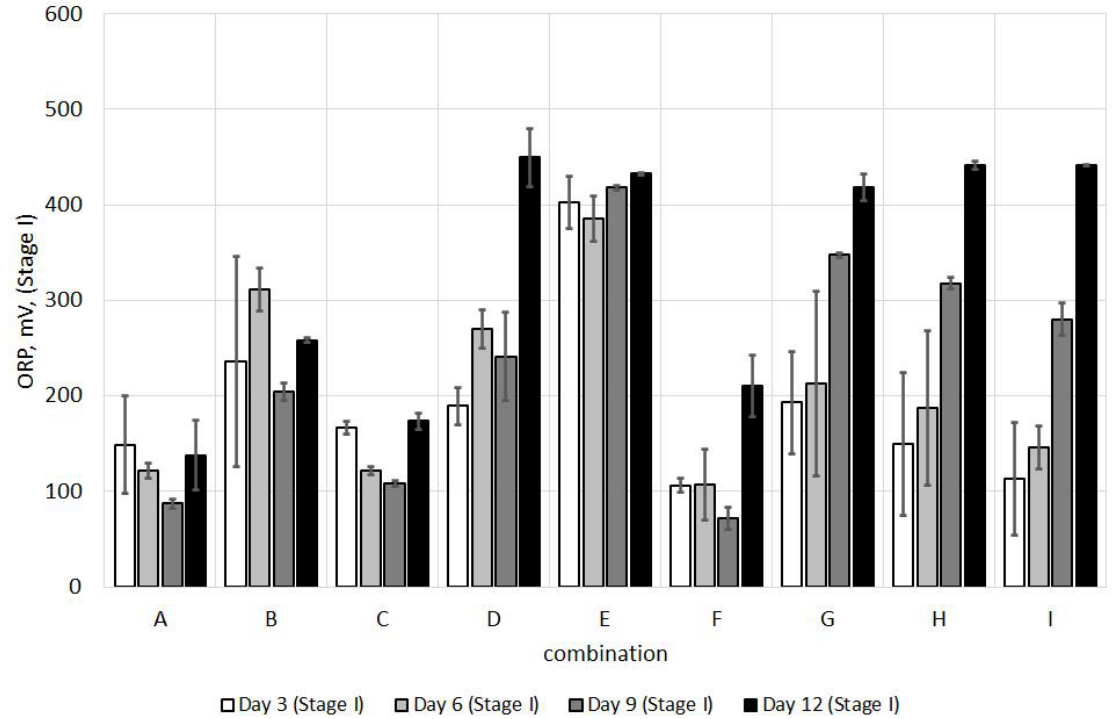
Figure 3. The oxidation and reduction potential of the samples analyzed in Stage I.